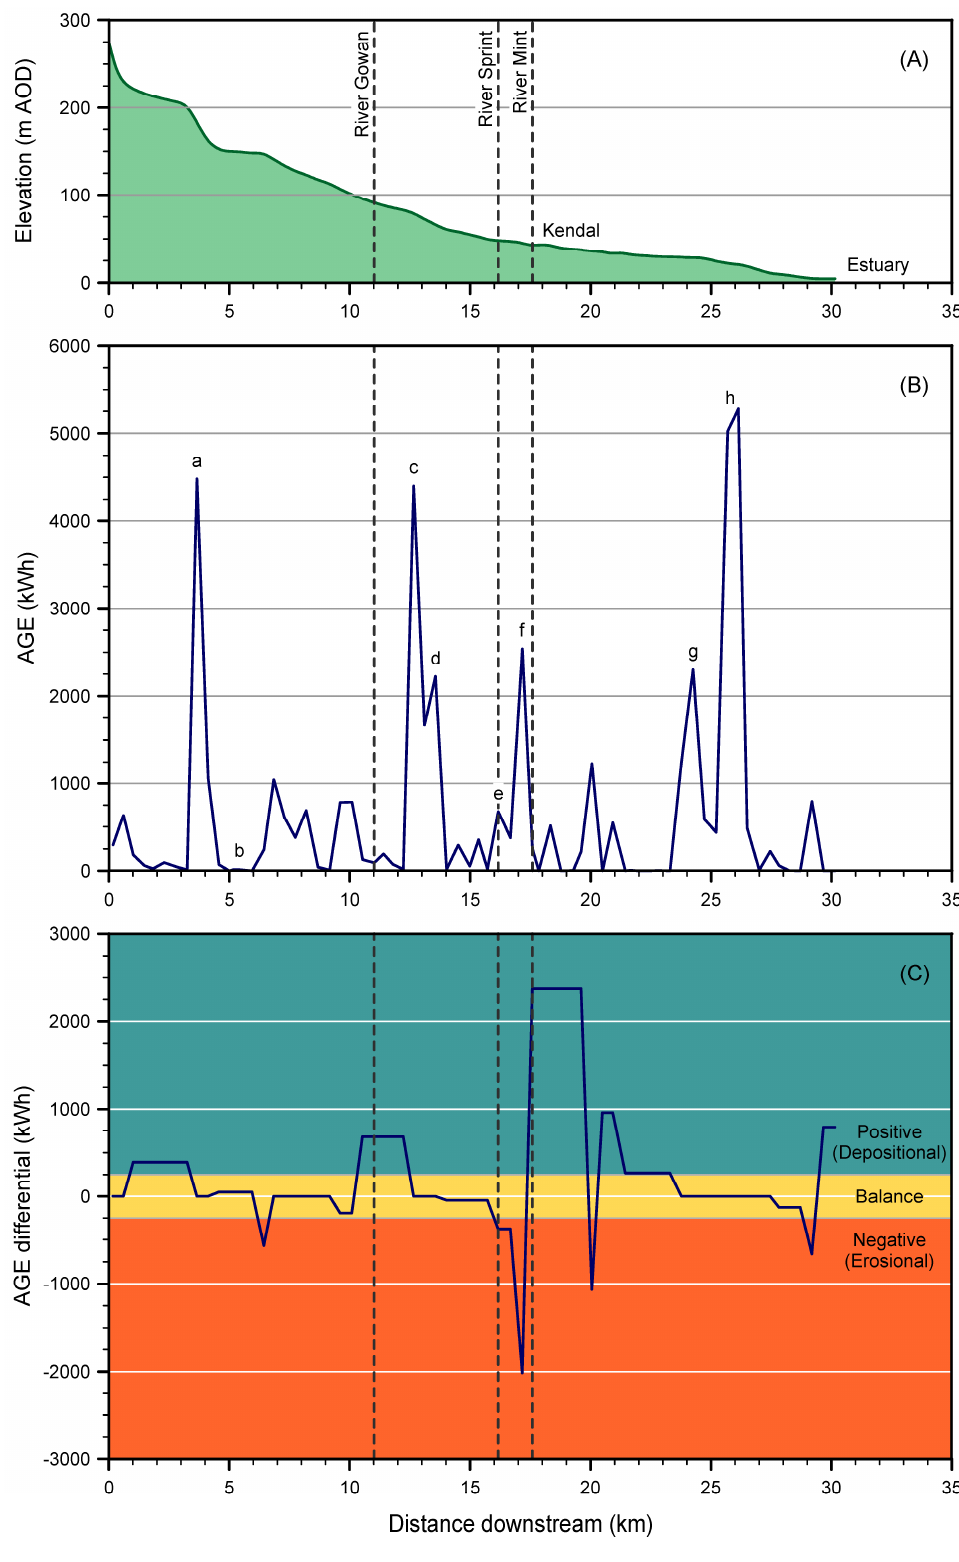
Figure 2. Annual Geomorphic Energy (AGE) along the main stem of the River Kent, Cumbria, UK. ( A ) Longitudinal profile (Above Ordnance Datum, AOD); ( B ) AGE values; ( C ) AGE balances (differentials).